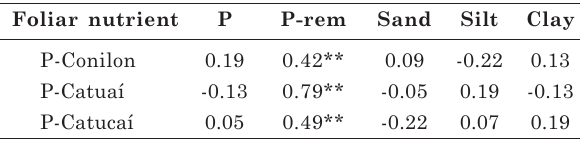
Table 1. Pearson’s linear correlation and its levels of